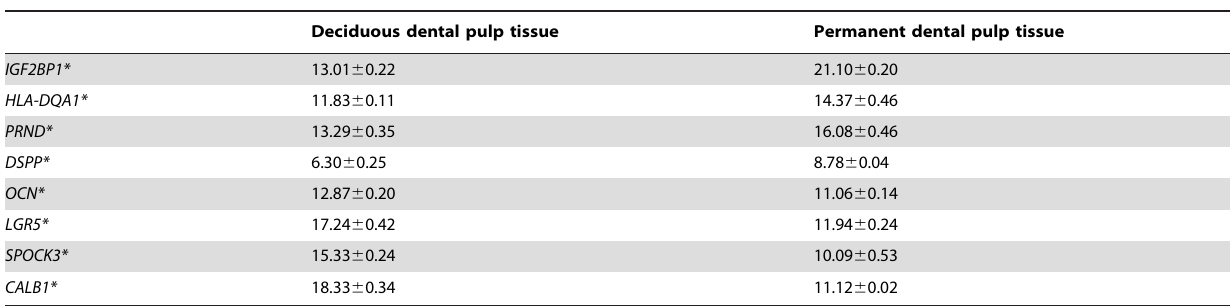
Table 4. D Ct values of deciduous and permanent dental pulp